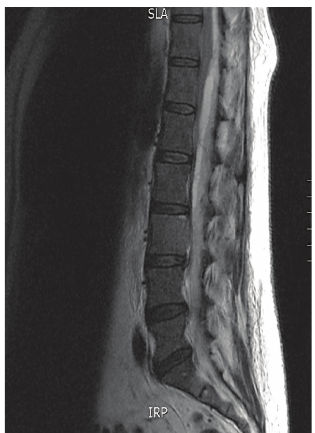
Figure 1: MRI of the lumbar spine in sagittal projection showing critical long segment spinal cord compression extending approxi- mately from the T12, left paraspinal intramuscular hematoma level, inferiorly to the L5.